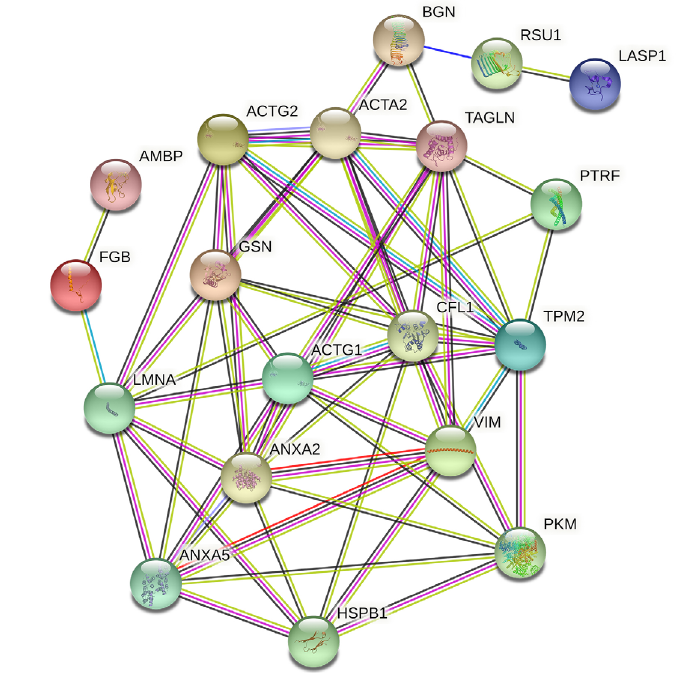
Figure 3 - Protein-protein interaction maps of the differentially expressed protein spots in artery of obstructive jaundice patients. The STRING toll (https://cn.string-db.org) was used to make the networks and analysis the biological process. The line color indicates the type of the interaction evidence. Network nodes represent proteins splice isoforms or post-translational modifications are